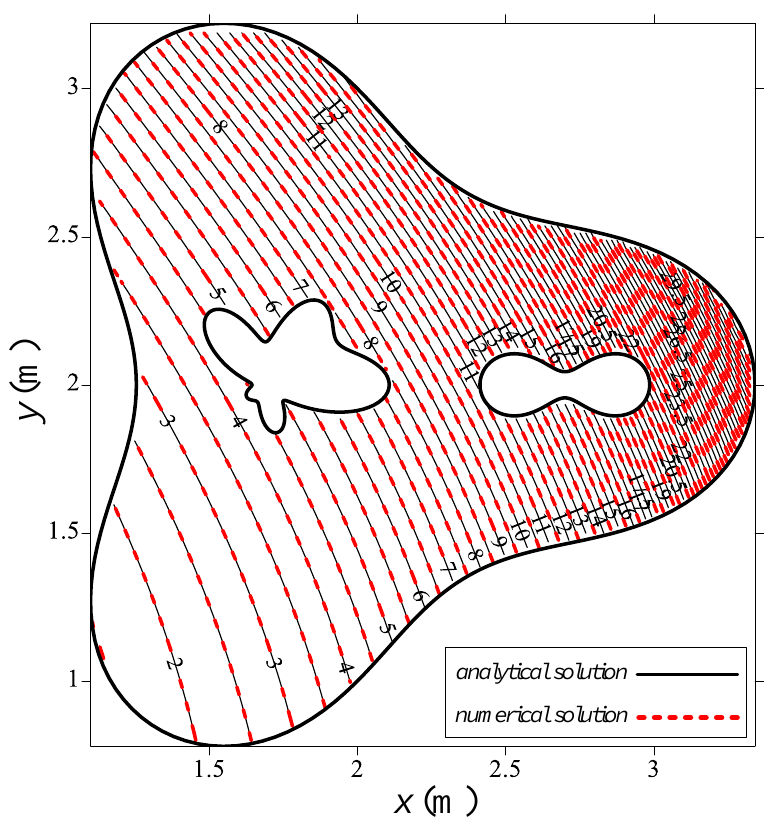
Figure 16. Results comparison with the exact solution.